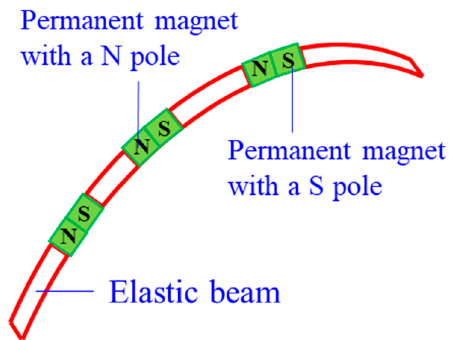
Figure 11. A permanent-magnet CCR [103].